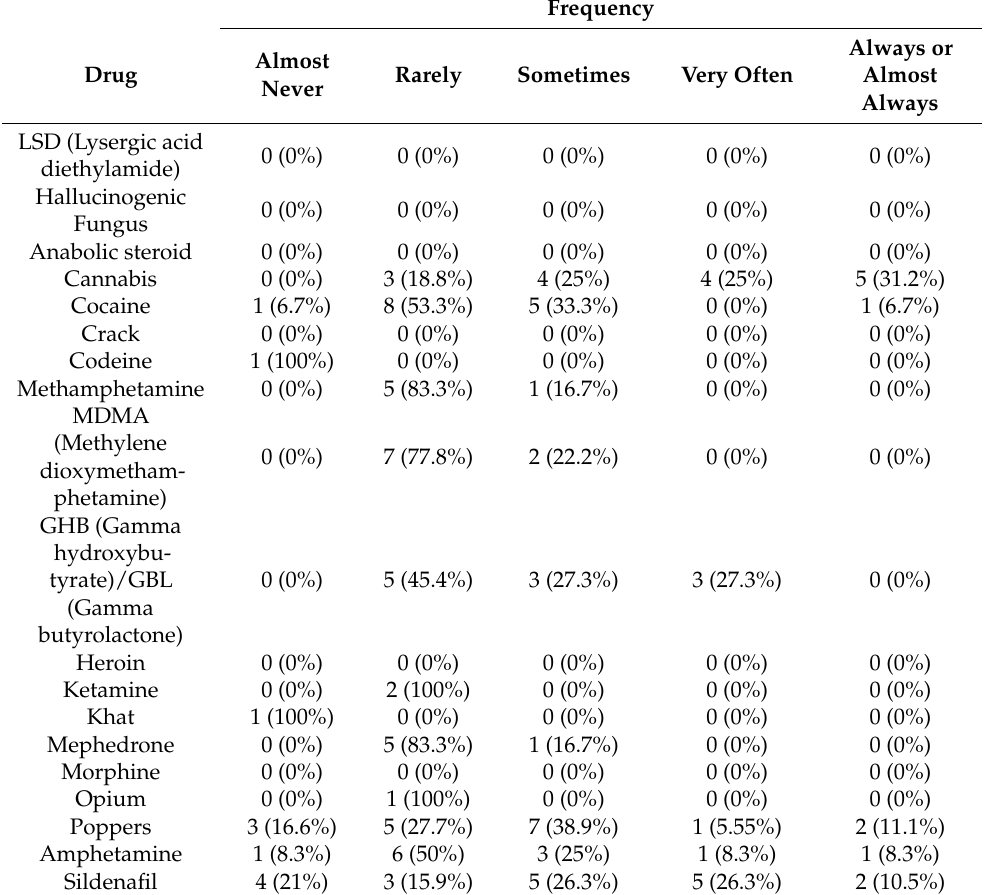
Table 3. Frequency of type of drug